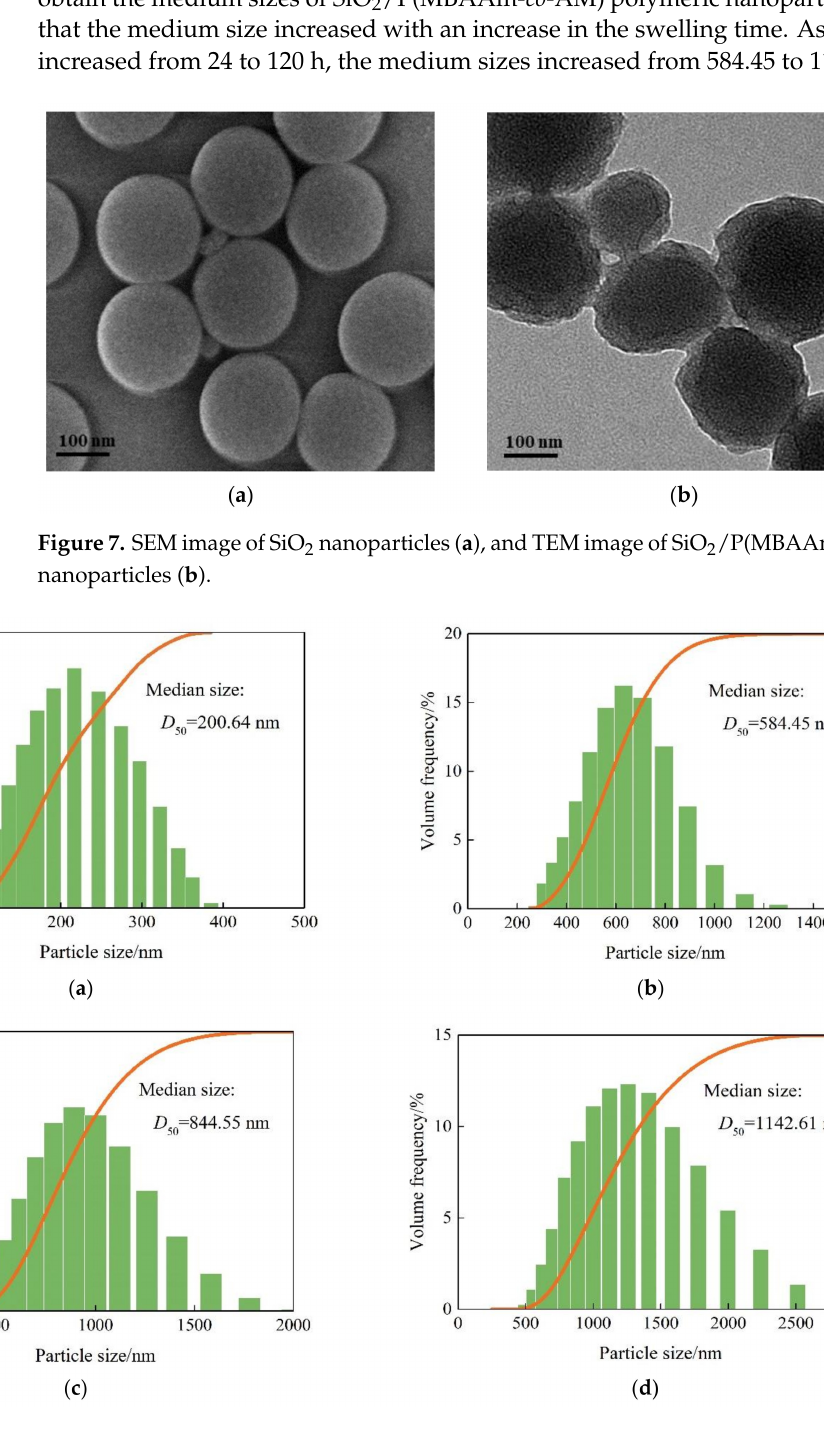
Figure 8. Particle size distribution curves of SiO 2 nanoparticles ( a ) and SiO 2 /P(MBAAm- co -AM) polymeric nanoparticles swelled for 24 ( b ), 48 ( c ), and 120 h ( d ) at a temperature of 60 ◦ C and a mass concentration of 1500